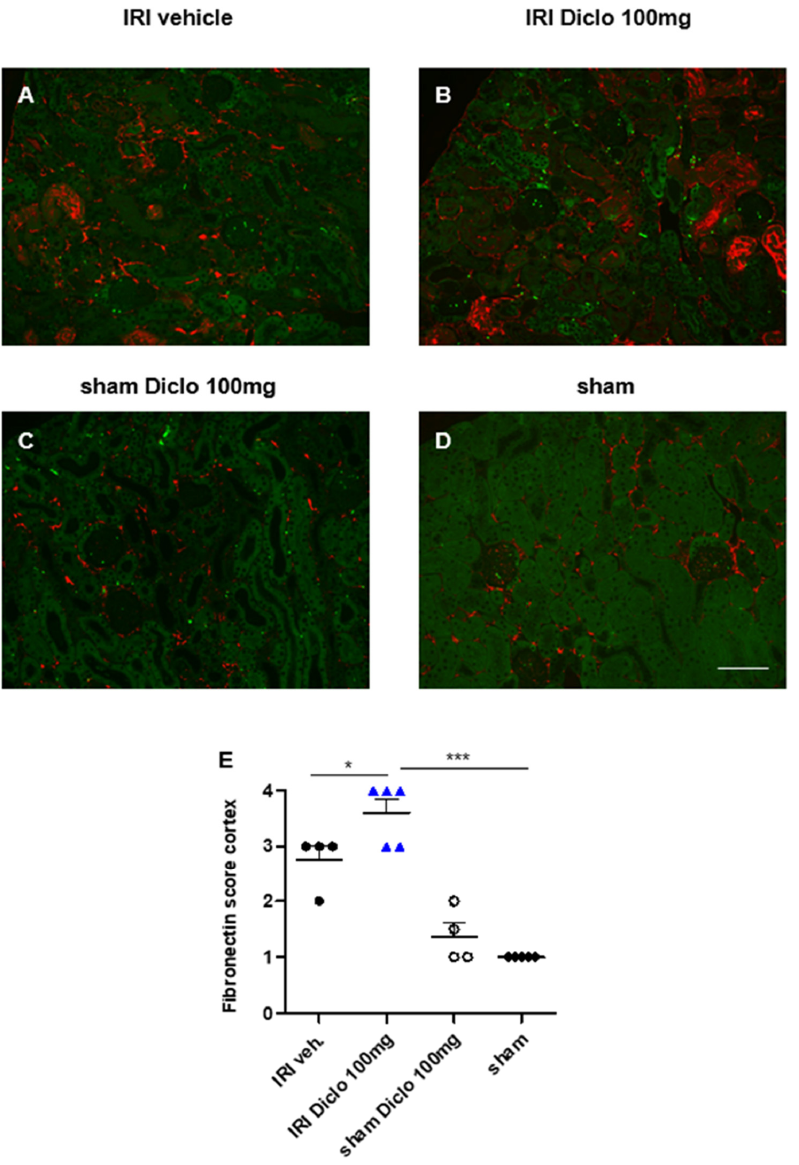
Figure 5. Renal fibronectin expression three days after renal ischemia–reperfusion injury (IRI) and repetitive diclofenac treatment. Fibronectin-stained kidney sections of IRI mice treated with vehicle ( A ), or repetitive doses of 100 mg diclofenac ( B ) over three days are shown. Sham-operated mice treated with 100 mg diclofenac over three days ( C ) and vehicle-treated sham m ( D ) served as control. Semi- quantitative scoring of renal fibronectin expression is shown in ( E ). Repetitive doses of diclofenac after IRI significantly increased renal fibronectin expression as an early pro-fibrotic indicator after three days. Diclofenac treatment in the setting of sham surgery did not cause significant renal fibronectin expression compared with sham surgery with vehicle treatment (E). n = 4–5 m each group are shown. * p < 0.05, *** p < 0.001. Scale bar 100 µ